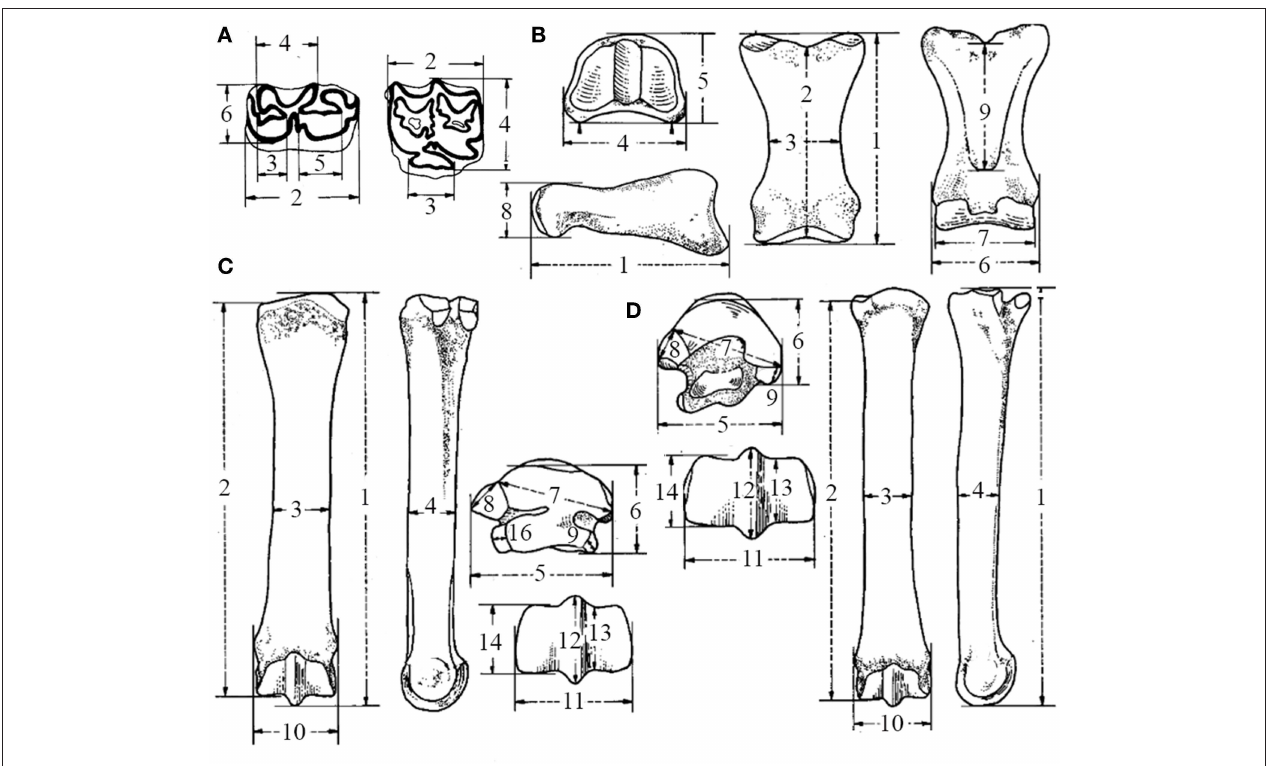
FIGURE 1 | Dimensions used for teeth and autopodial analyses, according to the Hipparion Conference (Modified from Eisenmann et al., 1988): (A) Lower dentition (left) (2) occlusal length, (3) length of the preflexid, (4) length of the double-knot, (5) length of the postflexid, (6) maximal width; upper dentition (right) (2) occlusal length, (3) occlusal length of the protocone, (4) occlusal width; (B) IPHIII (2) anterior length, (3) minimal breadth, (4) proximal breadth, (5) proximal depth, (6) distal breadth at the tuberosities, (7) distal articular breadth, (8) distal articular depth, (9) minimal length of the trigonum phalangis; (C) MCIII and (D) MTIII (2) medial length, (3) minimal breadth, (4) depth of the diaphysis, (5) proximal articular breadth, (6) proximal articular depth, (7) maximal diameter of the articular facet for the third tarsal/carpal, (8) diameter of the articular facet for the fourth tarsal/carpal, (9) diameter of articular facet for the second tarsal/carpal, (10) distal maximal supra-articular breadth, (11) distal maximal articular breadth, (12) distal maximal depth of the keel, (13) distal minimal depth of the lateral condyle, (14) distal minimal depth of the medial condyle, (16) diameter of the posterior facet for the fourth carpal.